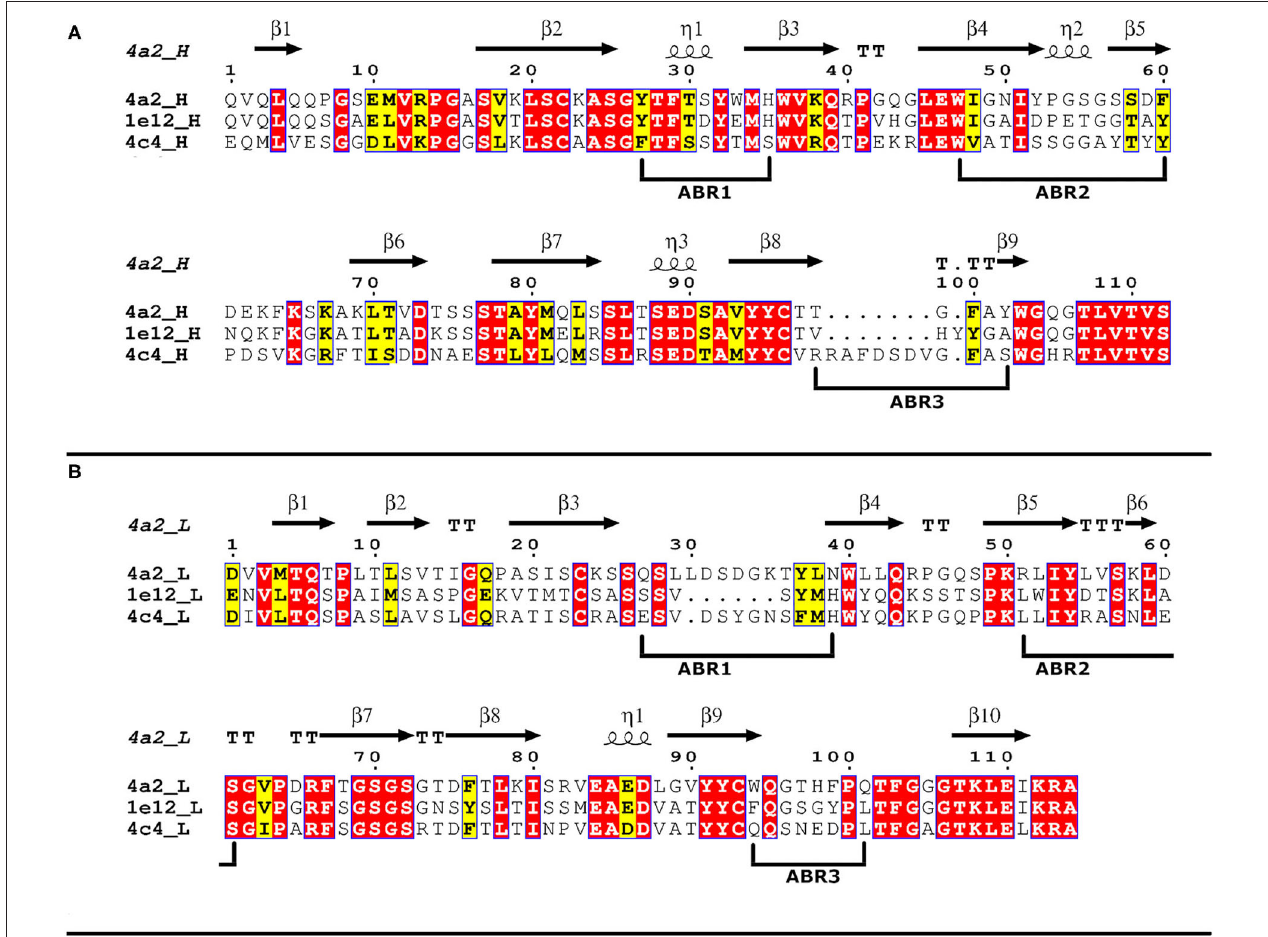
FIGURE 1 | Multiple-sequence alignments of anti-foot-and-mouth disease virus (FMDV) mAb Fv sequences. Amino acid Fv sequences of 4A2, 1E12, and reference 4C4 mAbs. Invariant and conserved residues are highlighted in red and yellow, respectively. Residues are numbered according to the Kabat numbering system and secondary structure elements for variable sequences are indicated above the sequence [spirals, α , and 310( η )-helices; arrows, β -strands; T, turns]. Antigen-binding regions (ABR) are underlined for H (A) and L (B) chains.